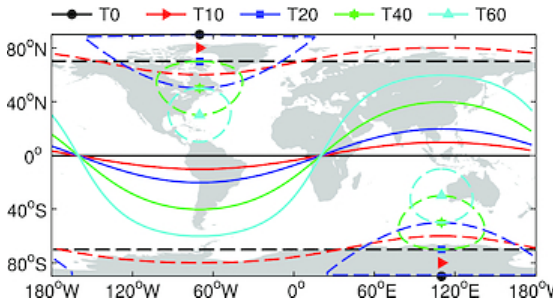
Figure 12. The locations of the magnetic poles (markers), the approximate locations of the polar caps (dashed lines), and the location of the magnetic equator (solid lines) for tilt angles of 0, 10, 20, 40, and 60° (labeled as T0, T10, etc.). The longitude of the Northern Hemisphere (NH) magnetic pole was set to 70° W in all cases, and correspondingly, the longitude of the Southern Hemisphere (SH) magnetic pole was set to 110° E. The polar caps were approximated as circles with a 20° radius around the magnetic poles (distortion of the circular shape is due to the projection). (Reproduced from Cnossen and Richmond [18]: Figure 1).